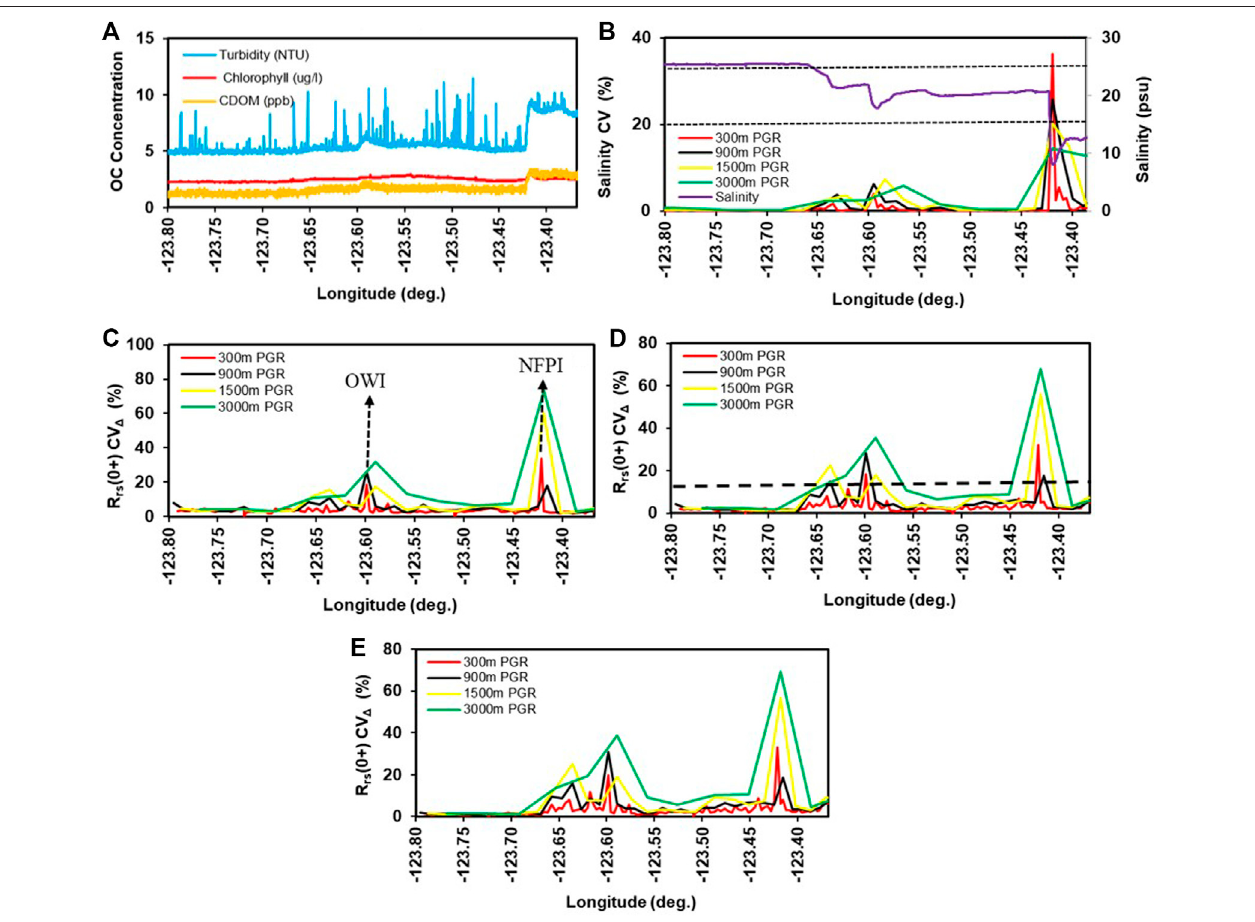
FIGURE 5 | Spatial variability analysis plot for the SoG waters along cruise transact on 2 September 2019. (A) Optical component (OC) concentration – turbidity, chlorophyll and CDOM; (B) corresponding salinity variability and salinity (psu). Salinity thresholds at 25 psu and 15 psu were indicated with dotted lines; R rs (0+) coef fi cient of variability [R rs (0+) CV Δ (%)] at different PGR 300, 900, 1500, 3000 m for, (C) Band 3 (442.5 nm), (D) Band 5 (510 nm) and Band 6 (560 nm) (E) of Sentinel 3a, OLCI sensor. R rs (0+) CV Δ threshold value, 15% is indicated in the subplot (D) as a dotted line.